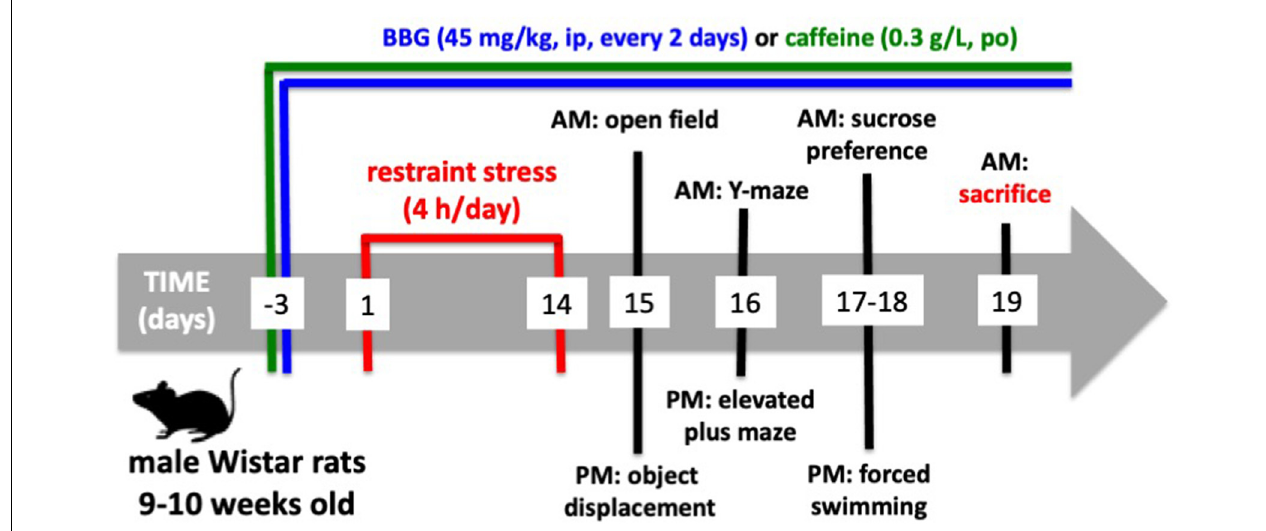
FIGURE 1 | Timeline of the